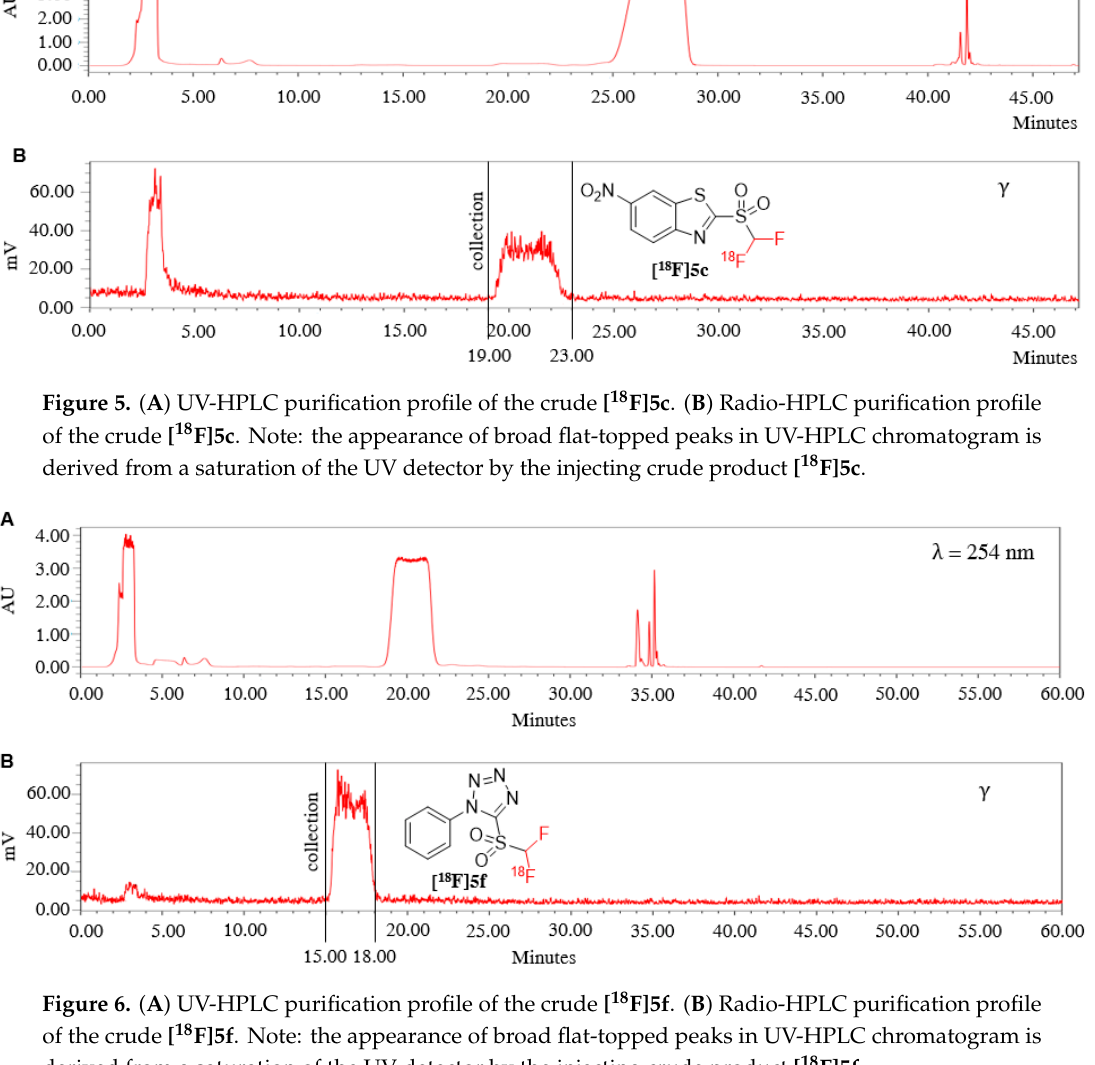
Table 3. Radiochemical yields and molar activities of the reagents [ 18 F]5a , [ 18 F]5c , and [ 18 F]5f.